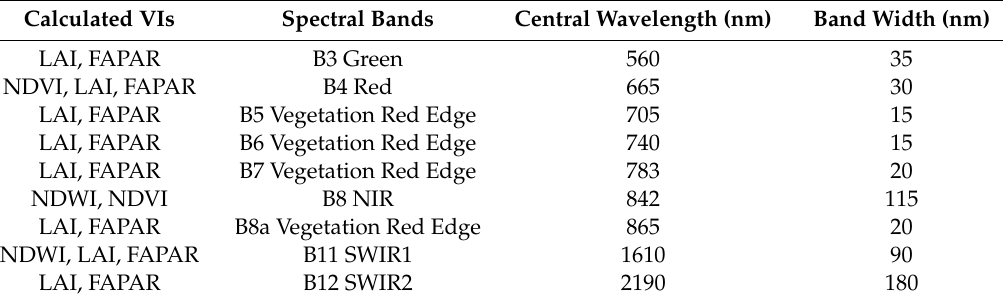
Table 2. Sentinel-2A Level-1C spectral bands and center wavelength used for VI